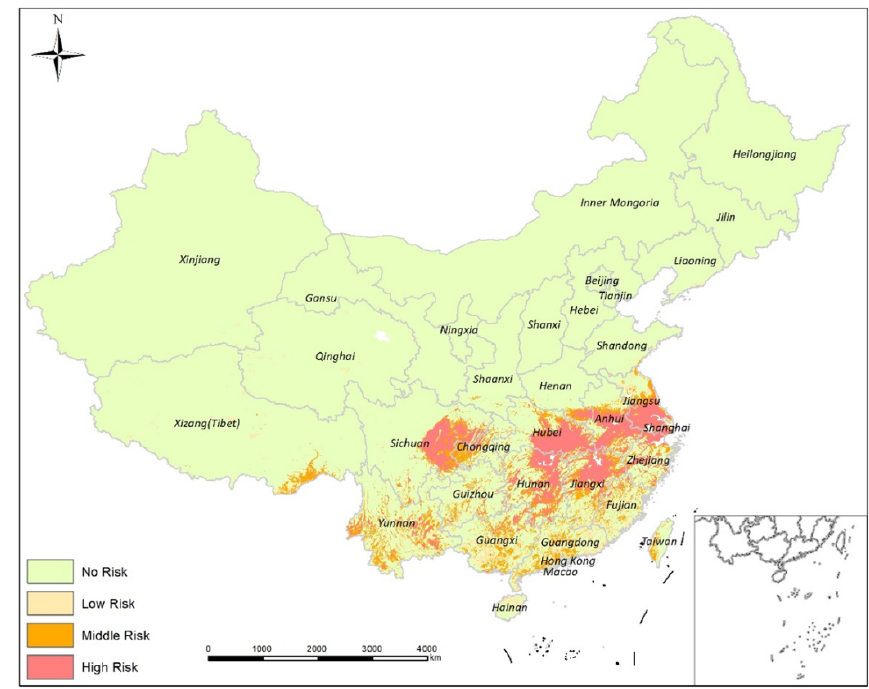
Figure 5. Mapping the risk of schistosomiasis transmission in China based on ensemble ecological niche modeling.